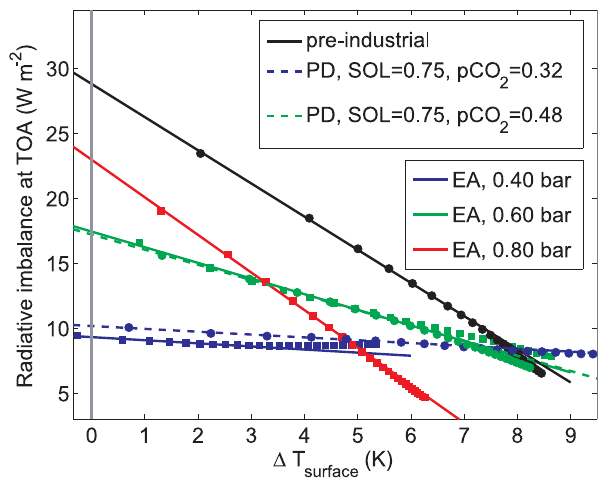
Fig. 9. Radiative imbalance at the top of the atmosphere when all clouds are removed instantaneously in different equilibrium climate states. Each point in the scatter plot corresponds to the mean value of one year. The linear fits are based on the first 9yr in all cases. The simulation of the pre-industrial climate has been performed with the model version including the technical changes as in Sect. 2.4. Note that the x-axis represents surface and not surface air